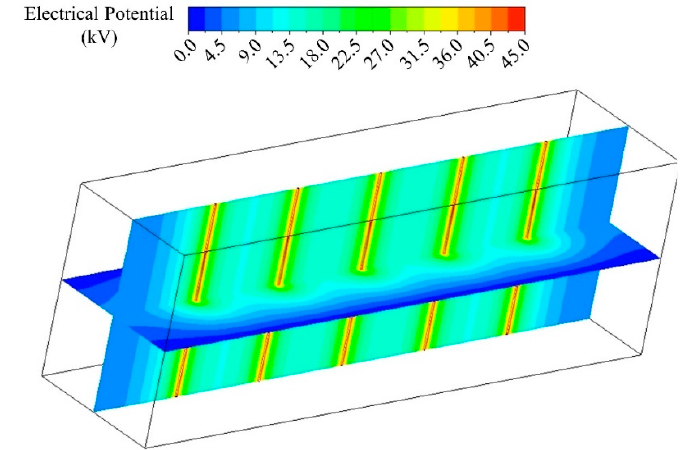
Figure 7. Distribution of electric potential values at the midplanes in the case of d w = 1 mm, 45 kV, and U in = 2 m/s in the 230 mm wide channel.